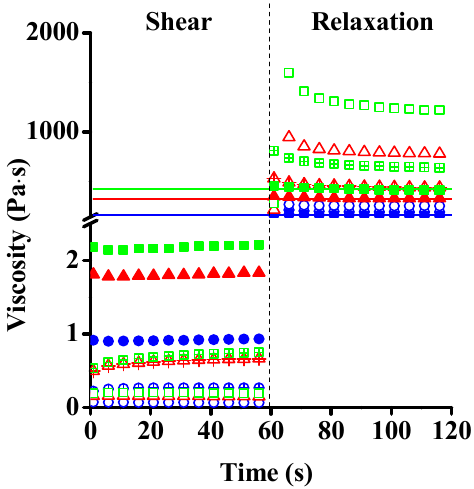
Figure 12. Change of viscosity of GO suspensions of different ages under high shear followed by relaxation at low shear rate. Constant shear rate of 100 s − 1 (open symbols), 1000 s − 1 (open symbols with a + sign) and 10,000 s − 1 (filled symbols) applied for 60 s followed by a relaxation at 0.1 s − 1 . 0 y—blue dots; 1 y—red triangles; 2 y—green squares.